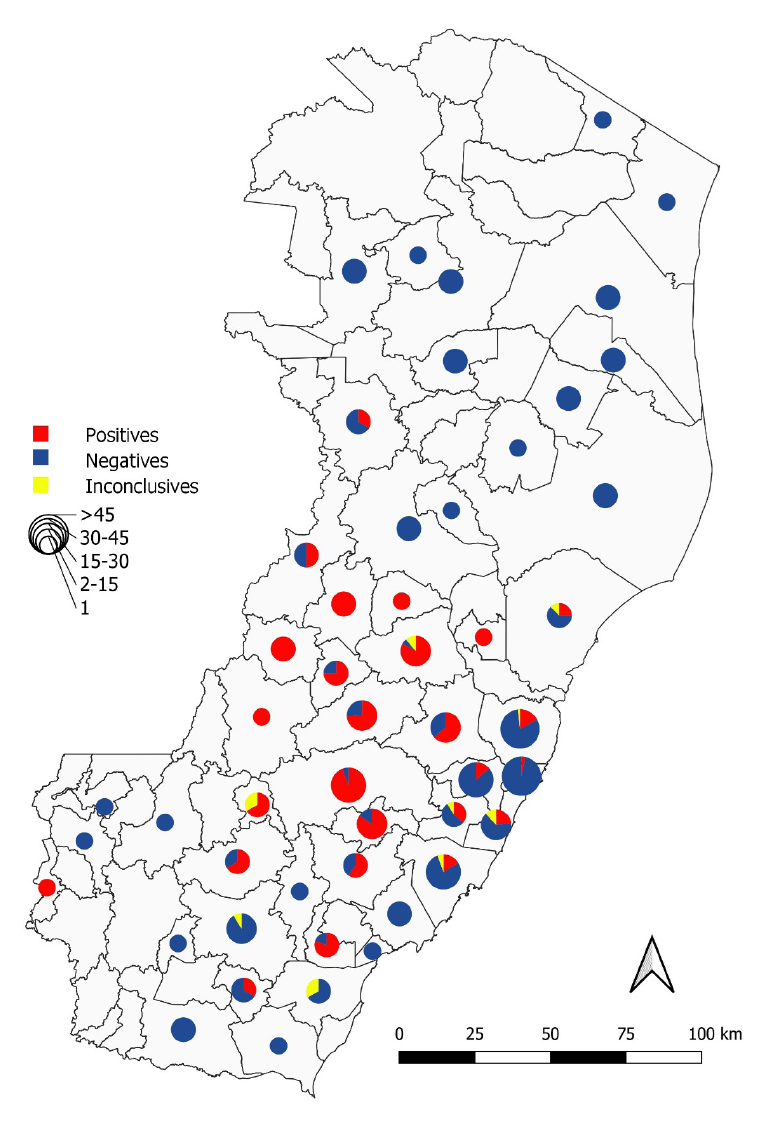
Figure 2. Results of